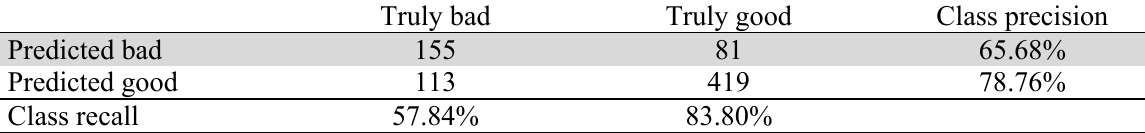
The results of W-J48 graft